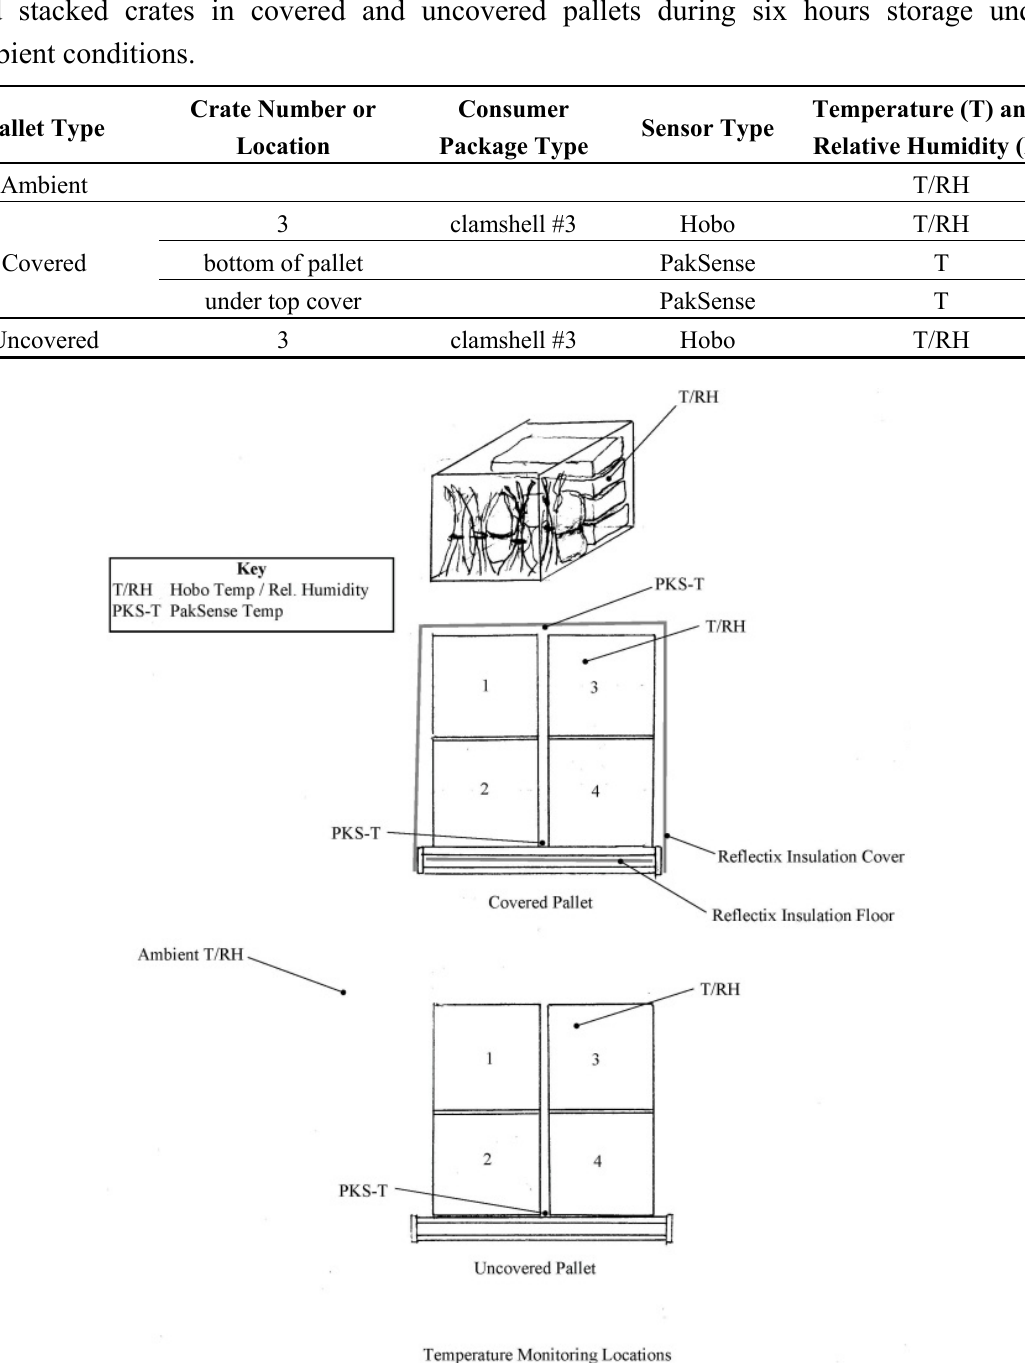
Figure 3. Temperature and relative humidity monitoring locations in both covered and uncovered pallets of